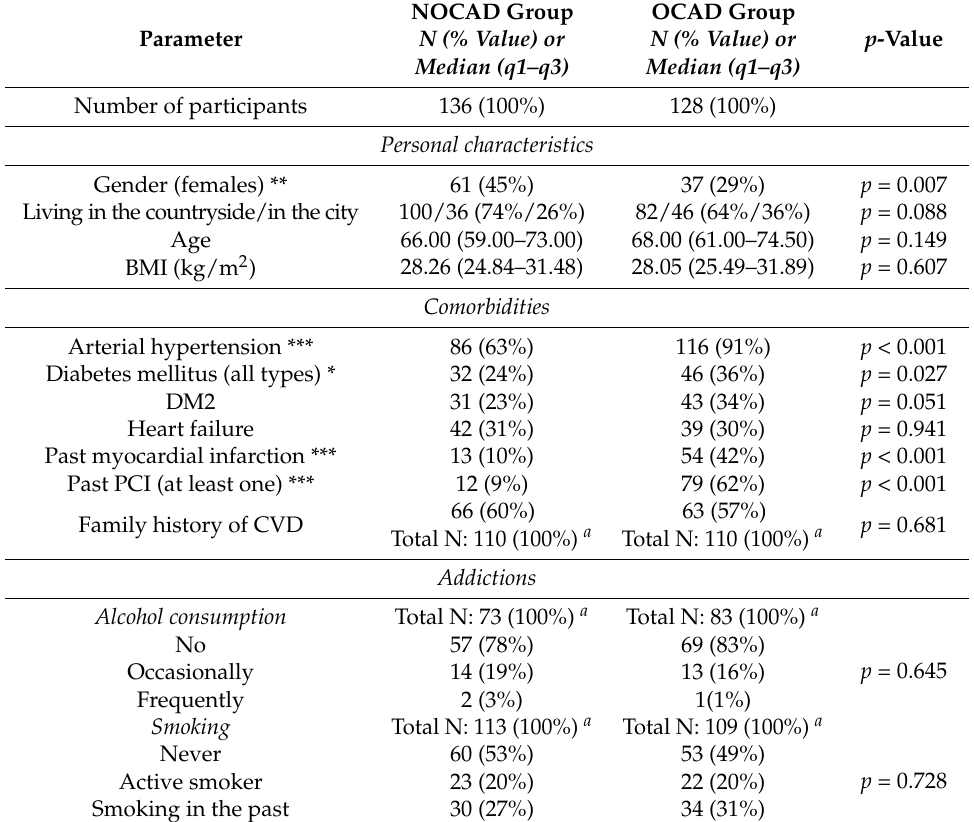
Table 1. Study population